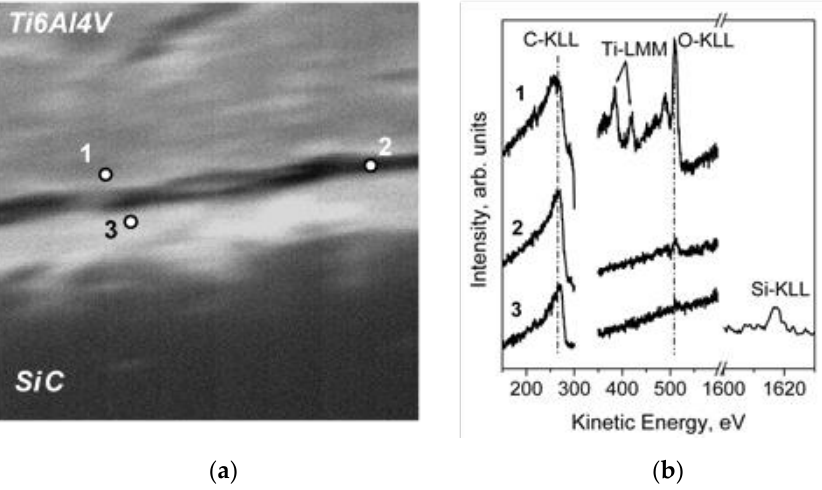
Figure 18. SEM image 80 × 80 µm 2 ( a ) and AES spectra ( b ) acquired on the cross section of the sample 1 across the carbon layer; analysis points are labelled 1, 2, and 3 [29]. Coatings 2020 , 10 , 1182